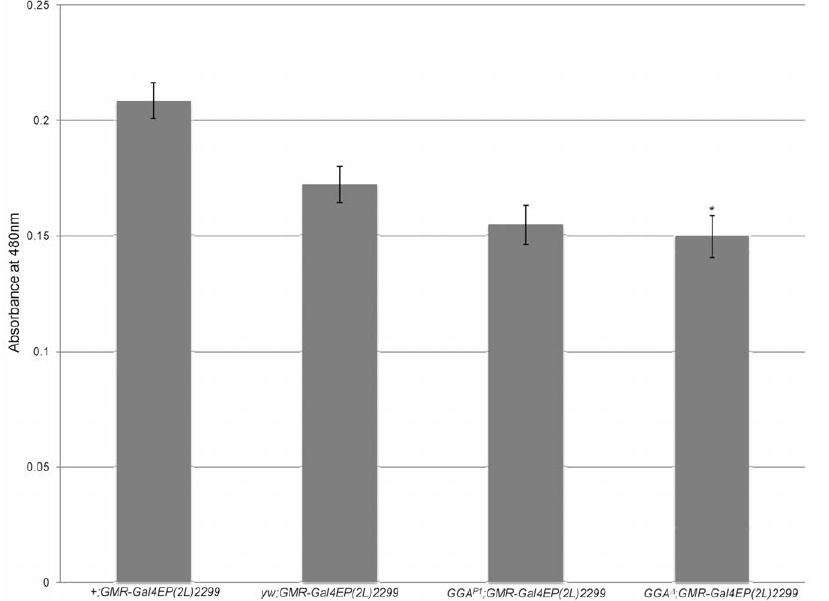
Figure 8. GGA knockout enhances the eye phenotype caused by Bchs overexpression. Control: Bchs overexpressing male + ; GMR-Gal4 EP(2L)2299, yw; GMR-Gal4 EP(2L)2299. Bchs overexpressing male knocked down or out for GGA: GGA P1 ; GMR-Gal4 EP(2L)2299 and GGA D ; GMR-Gal4 EP(2L)2299. Amount of extracted red eye pigment was measured at 480 nm. (*) GGA D ; GMR-Gal4 EP(2L)2299 showed significant reduction in red eye pigment compared with both + ; GMR-Gal4 EP(2L)2299 and yw; GMR-Gal4 EP(2L)2299 (P-value , 0.0008 and 0.04). GGA P1 ; GMR-Gal4 EP(2L)2299 showed only significant reduction in red eye pigment compared with + ; GMR-Gal4 EP(2L)2299 (P-value , 0.0003).